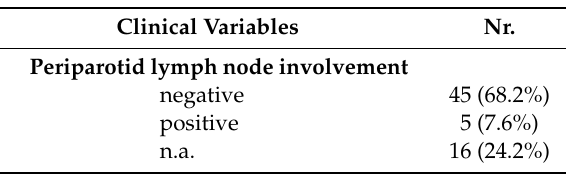
Table 2. Clinicopathological variables affecting lymph nodes metastasis.